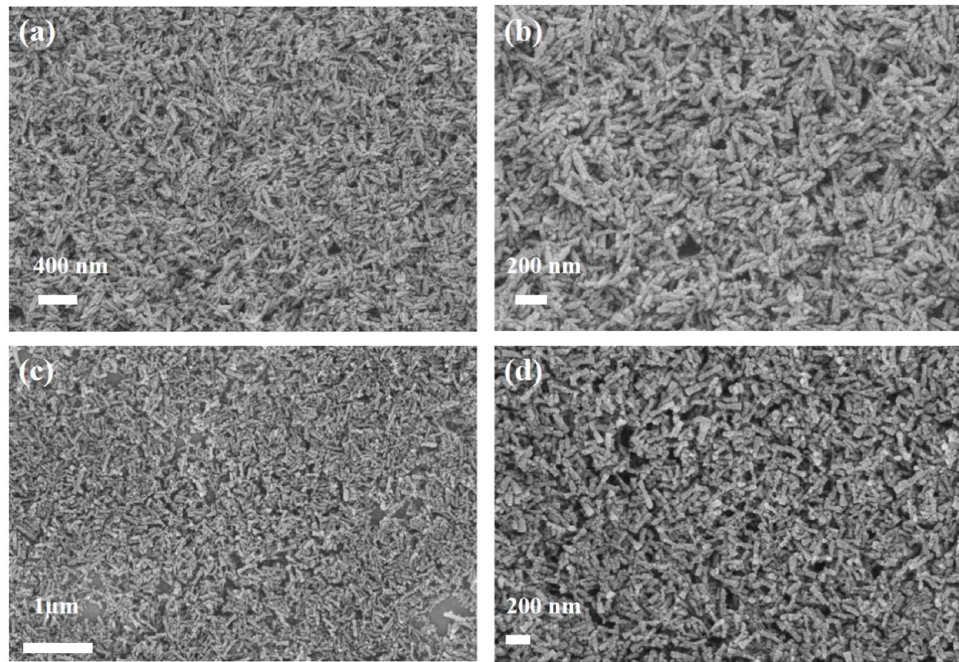
Figure 2. SEM images of ZSTU-2 ( a , b ) and NH 2 -ZSTU-2 ( c , d ).